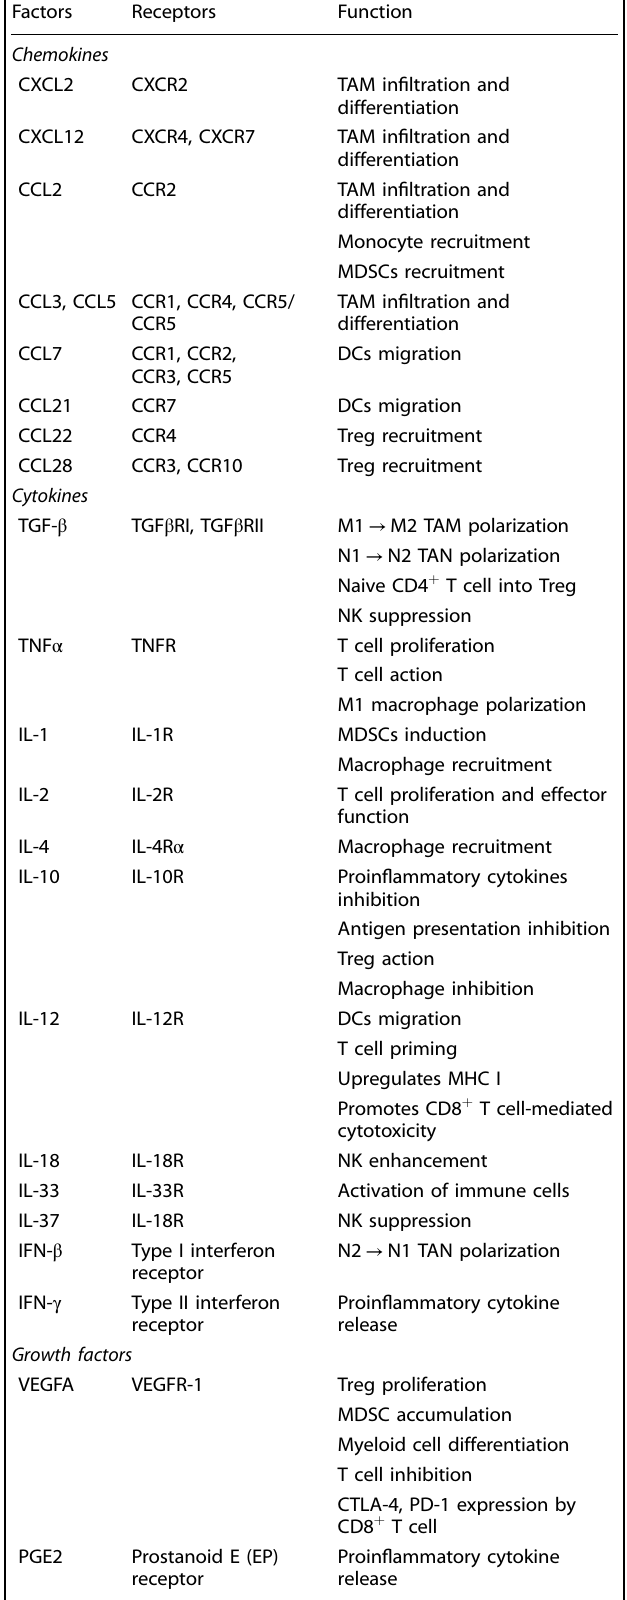
Table 1. Immunomodulatory factors and their functions in TME induced by radiation